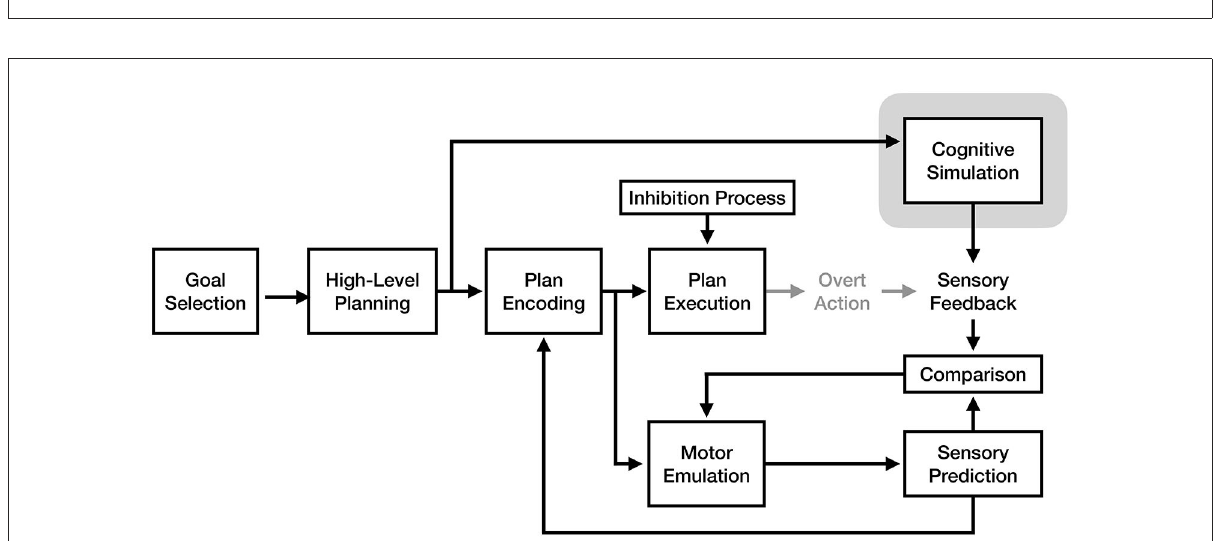
FIGURE8 A fusion model of motor imagery combining the motor-cognitive model’s cognitive simulation with the emulation and comparison mechanism from motor emulation theory. The component of the model responsible for the experience of motor imagery is enclosed in